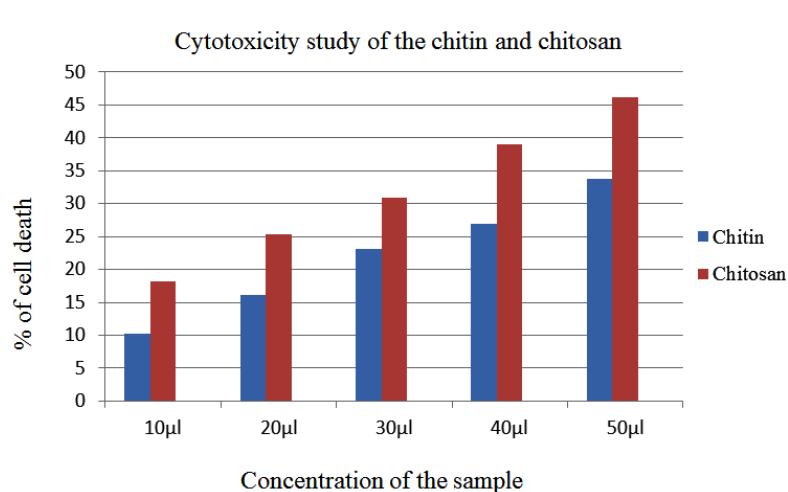
Fig. 12. Cytotoxicity study of the extracted polymer